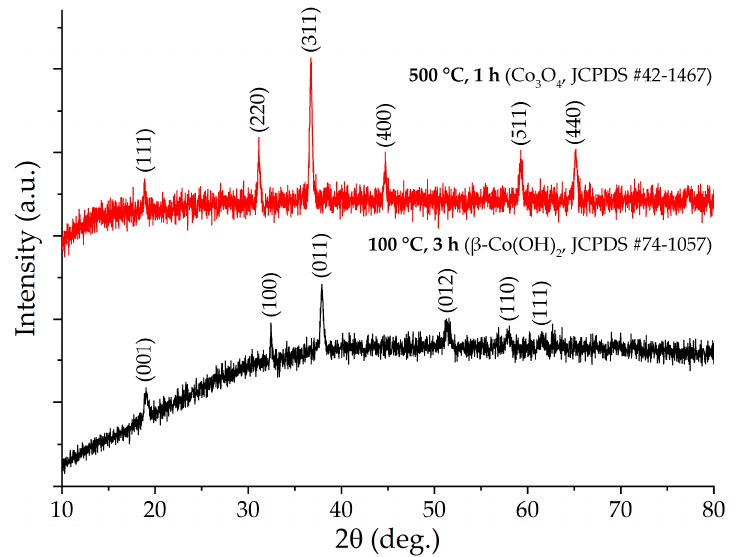
Figure 3. X-ray diffraction patterns of the semi-product ( bottom ) and the oxide powder obtained ( top ).